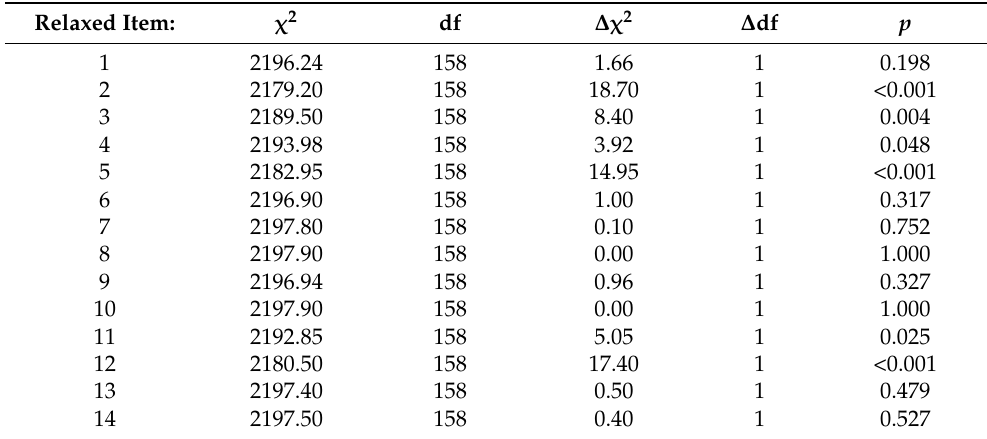
Table 5. Identification of the source of metric invariance in the modified MHC-SF factor structure. Relaxed